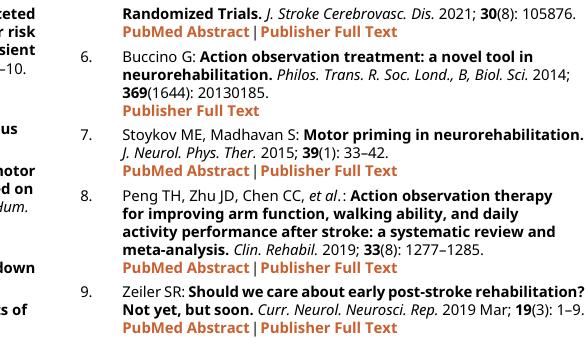
This project contains the following underlying